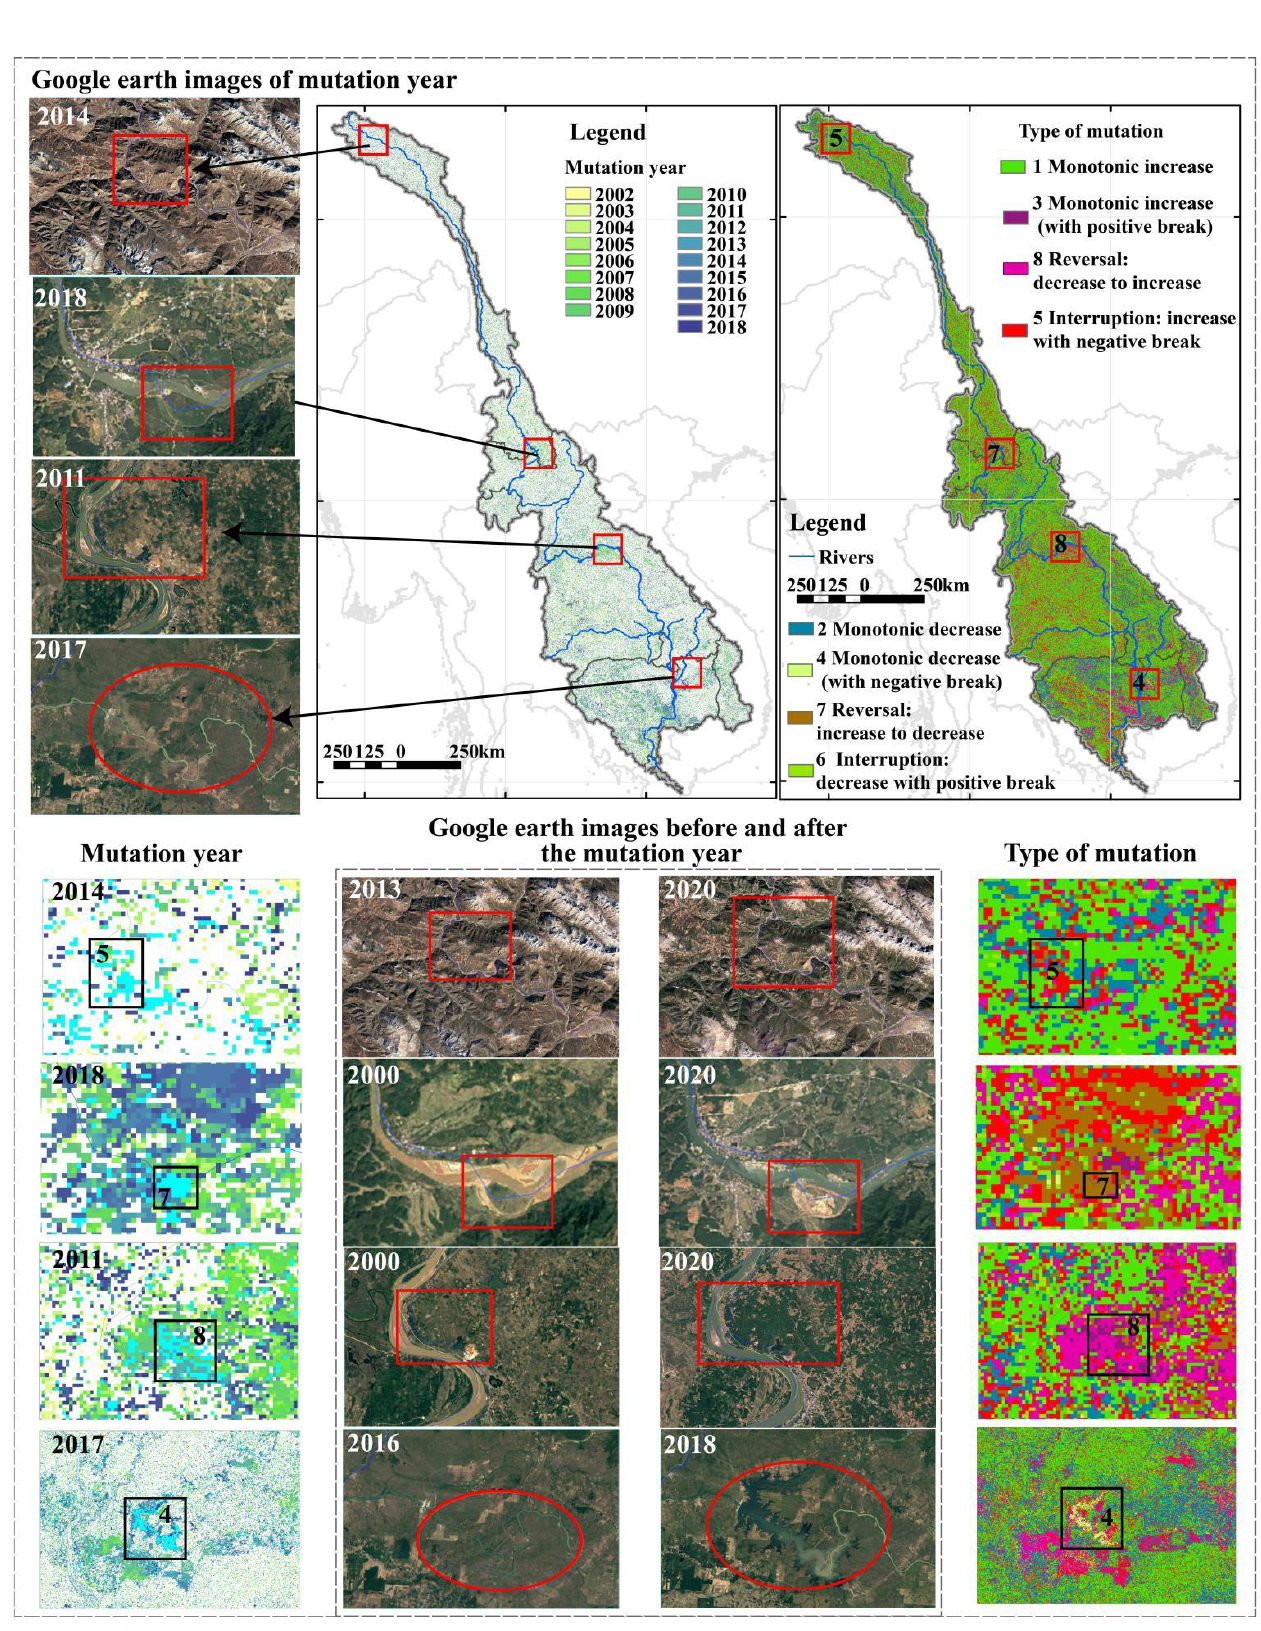
Figure 10. Visual comparison of Google Earth images before and after the mutation year. The numbers 4,5,7,8 in Figure represent the corresponding mutation type, in order to see the figure more clearly, use red squares and circles to highlight the range of the selected mutation year and mutation type in the picture.